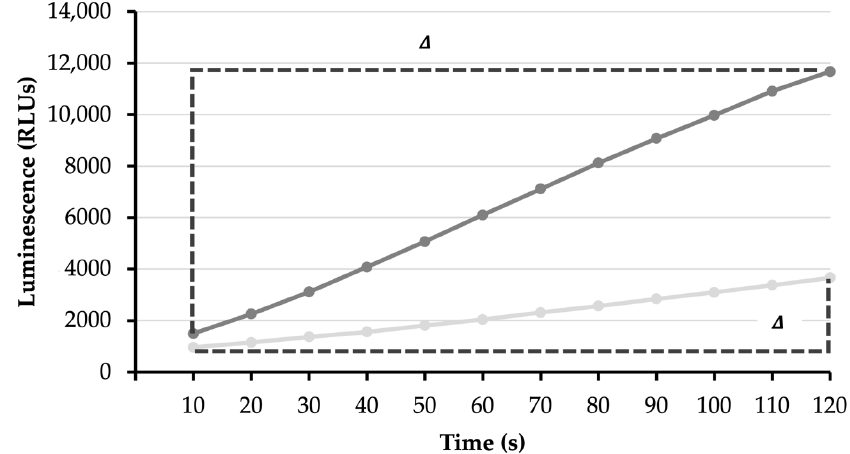
Figure A1. Mitochondrial adenosine triphosphate (ATP) synthesis is measured by the reaction of ATP with luciferase. With higher ATP synthesis, luciferase produces more light, which is measured by an increase in relative luminescence units (RLUs; compare dark grey to light grey lines). The difference ( Δ ) in RLUs over time determines the rate of ATP synthesis.